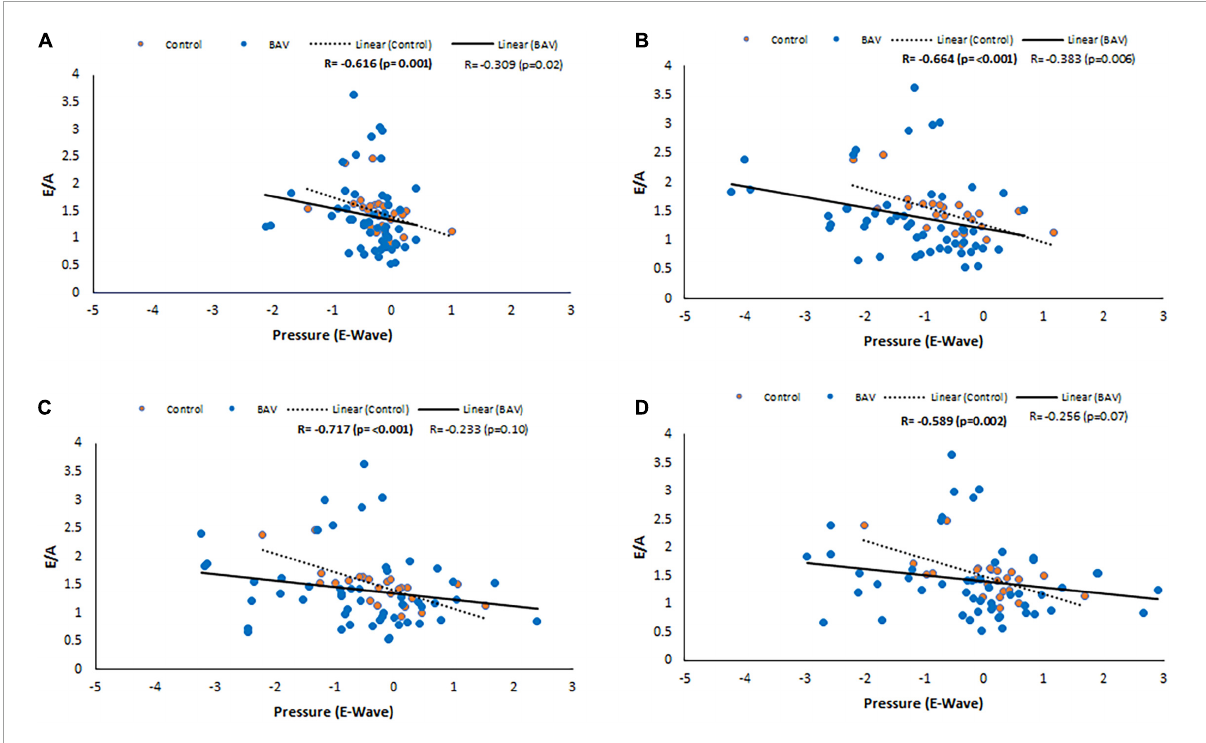
FIGURE6 E/A correlations with pressure at E-wave timepoint in control and BAV groups. The locations are shown at (A) LA middle part, (B) MV, (C) LV middle part, and (D) LV apex. Left atrium (LA), mitral valve (MV), and left ventricle